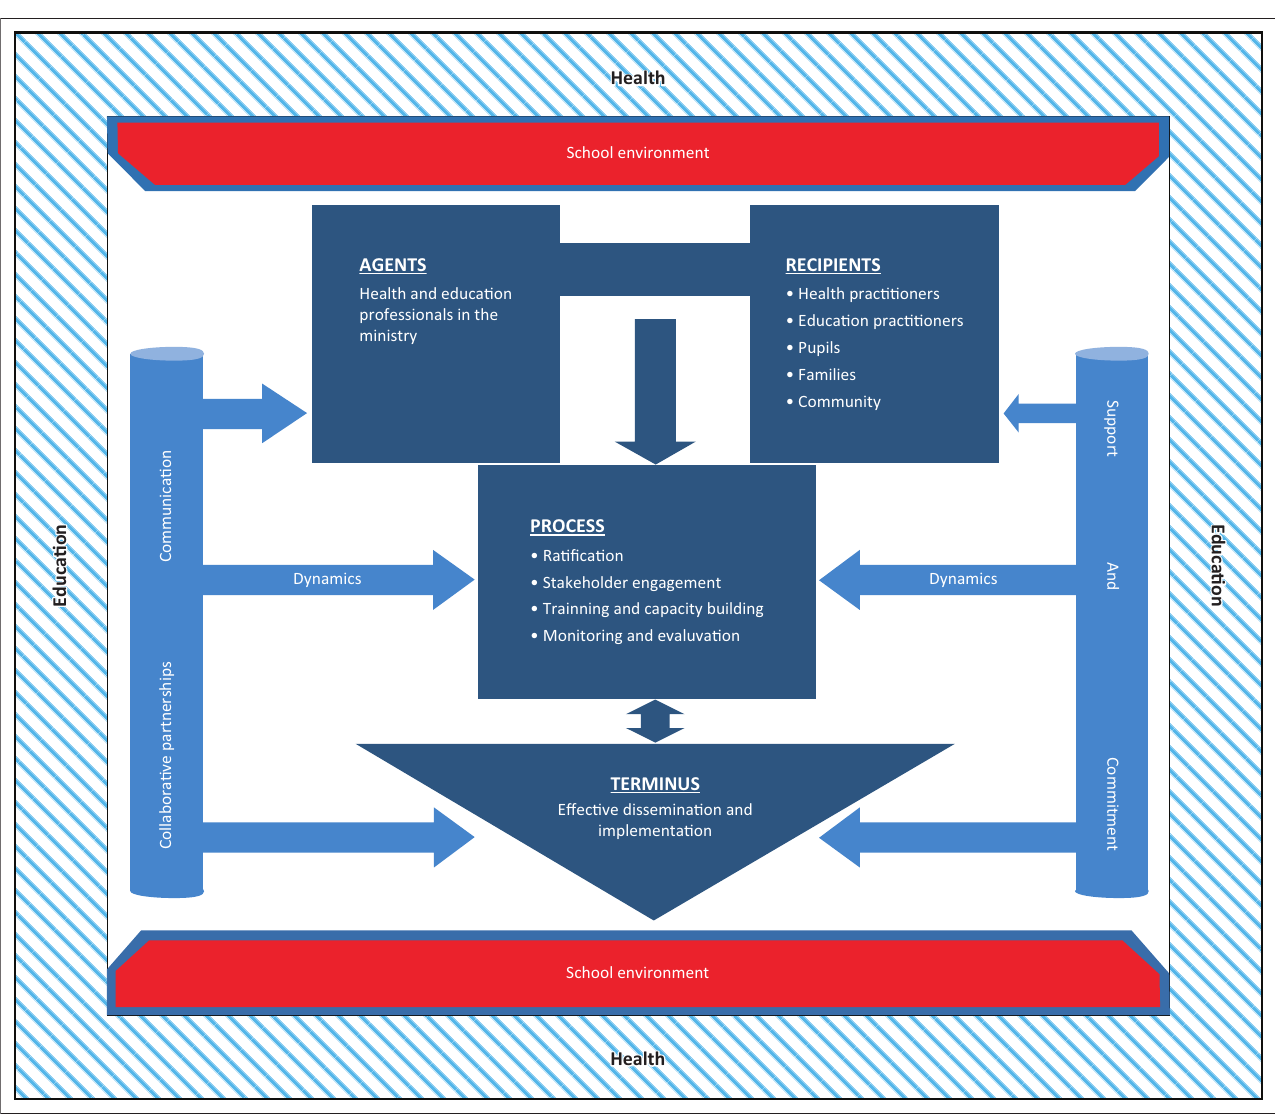
FIGURE 2: A conceptual framework for effective dissemination and implementation of a policy on school health in rural